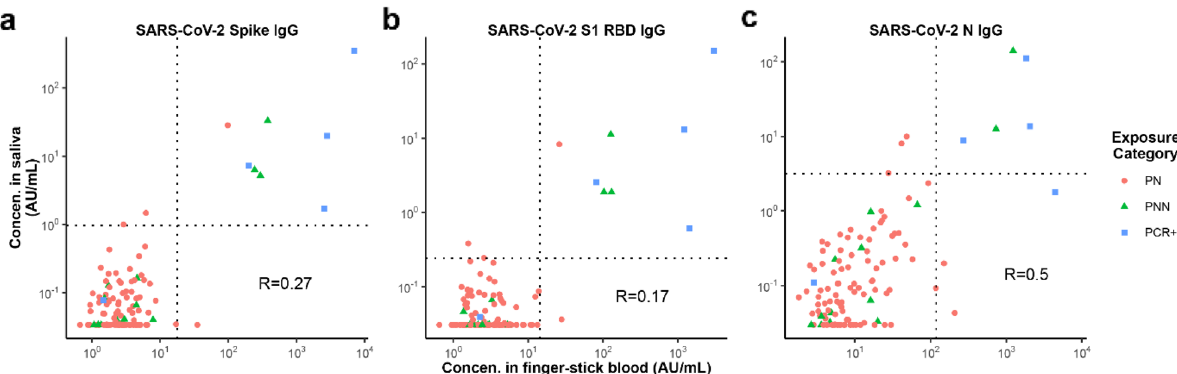
Figure 3. Correlation in reactivity to CoV-2 antigens measured in self-collected saliva versus finger-stick blood. Levels of IgG antibodies were measured in matched saliva and finger-stick blood provided by the same donors. Dotted lines indicate the selected classification thresholds. For each figure, the lower left quadrant contains samples that are within the range of non-specific reactivity for both saliva and finger-stick blood. The upper right quadrant are samples with high reactivity for both saliva and finger-stick blood.